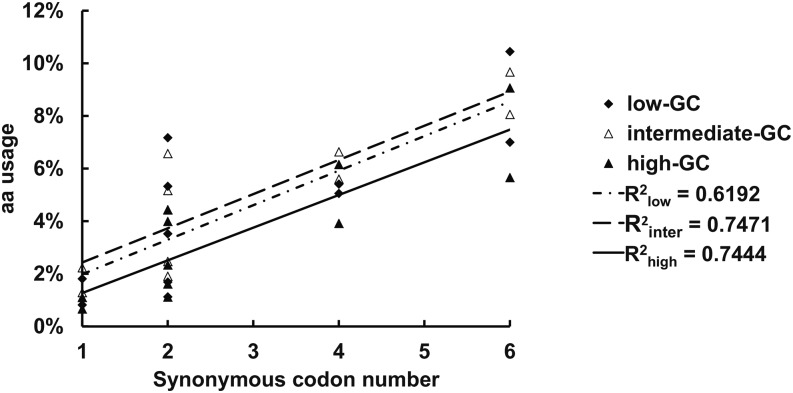
The correlation between amino acid usage and the number of synonymous codons for the 11 less variably used amino acids with intermediate-GCsyn at high- (0.79−0.80), intermediate- (0.50−0.51), and low-GC (0.3−0.31) regions.